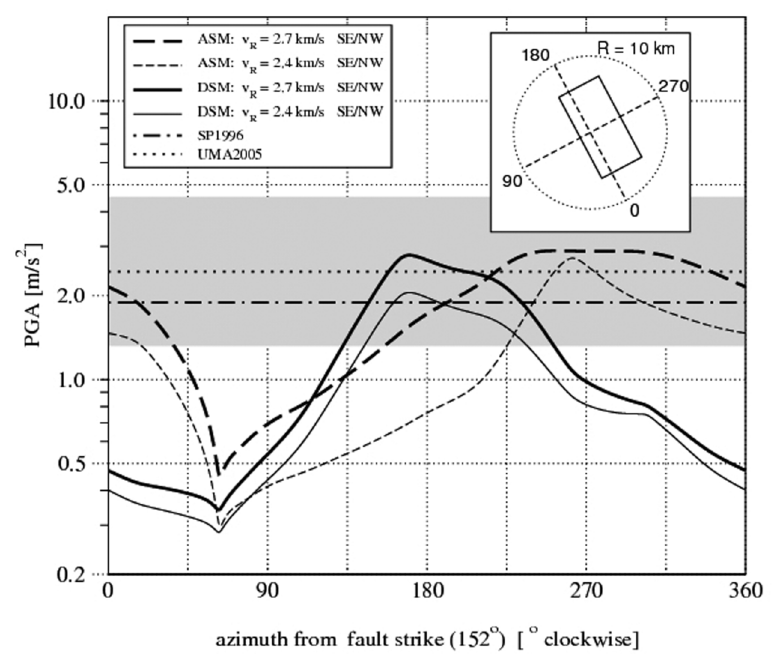
Fig. 6. PGA as a function of azimuth at 10 km epicentral distance predicted by synthetic simulations and by ground motion predictive equations. DSM and ASM simulations obtained with the unilateral SE/NW nucleation and with two values of the rupture velocity are compared with empirical predictions of Sabetta and Pugliese (1996) and UMA2005 (Bindi et al ., 2006) for a M6 earthquake. Shaded area indicates ±1std of UMA2005, and the inset shows the geometry adopted for the